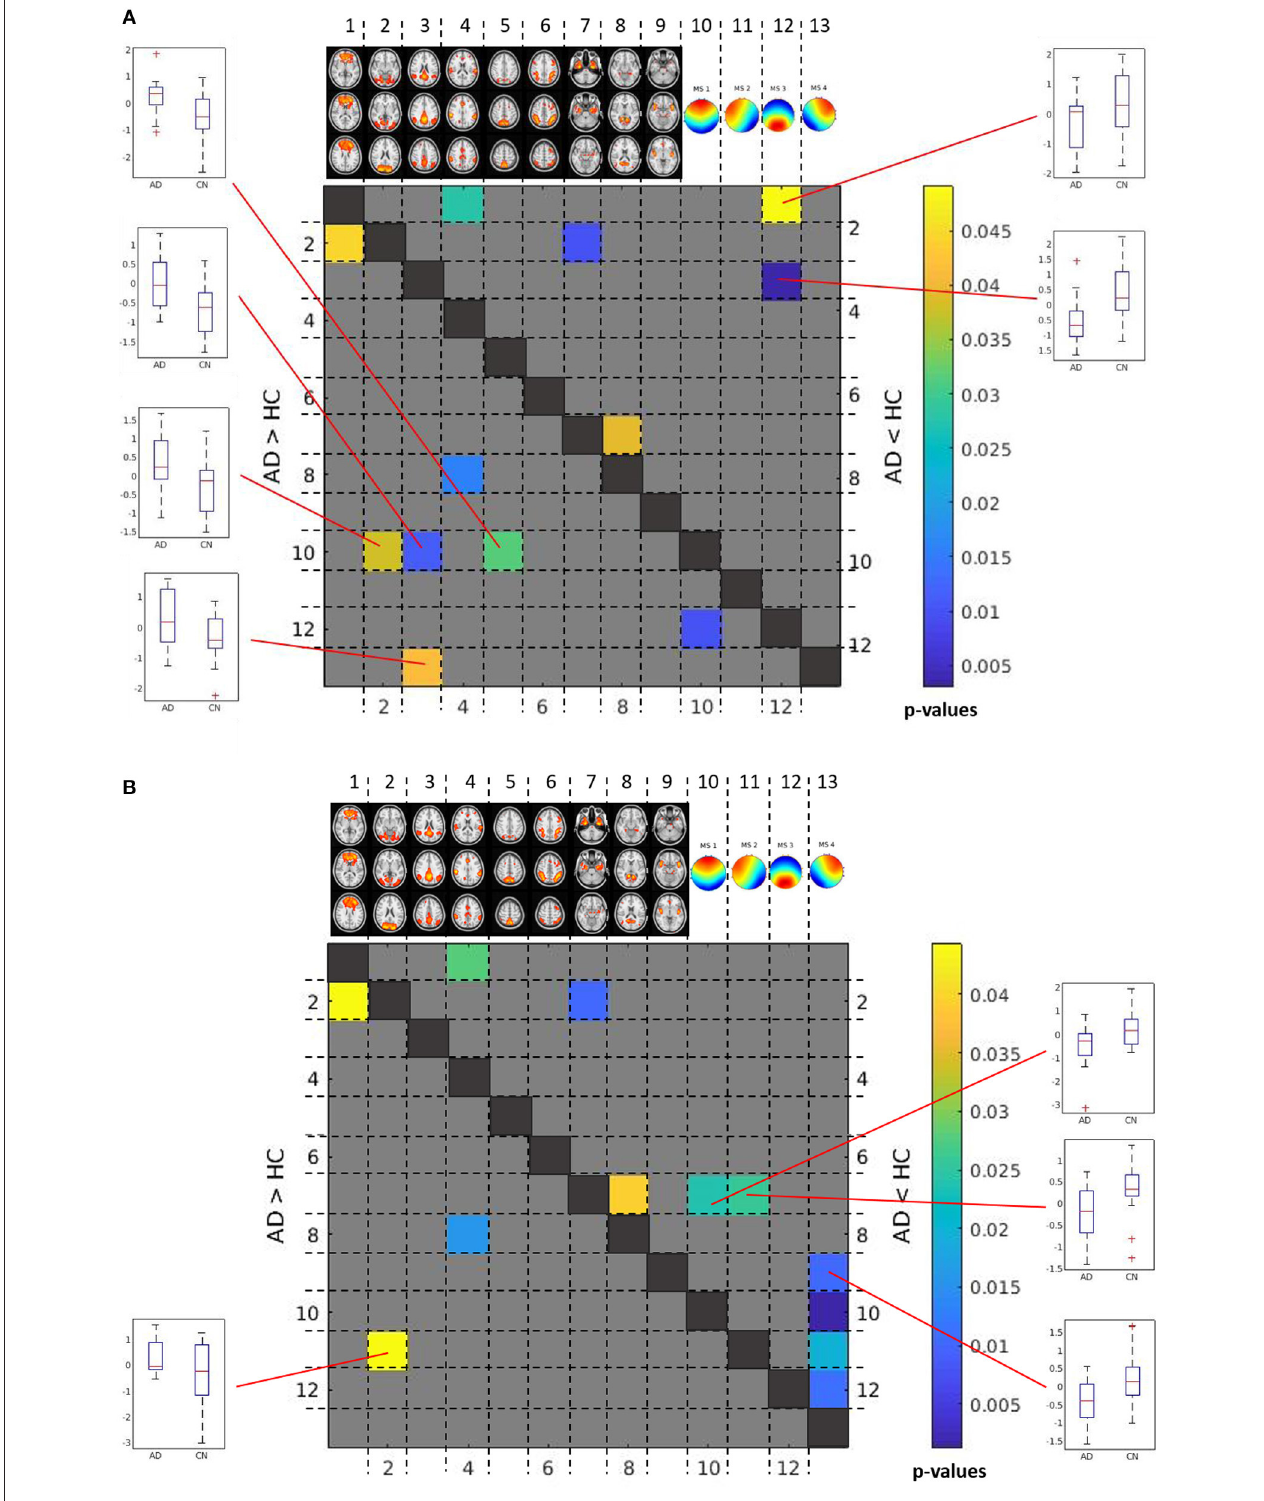
FIGURE 6 | Between group differences in between-network time course correlations. Matrix of differences in correlations between AD patients and controls in Fisher-Z-score correlation coefficients between time courses. The lower left triangular matrix highlights correlations that were less negative or more positive in